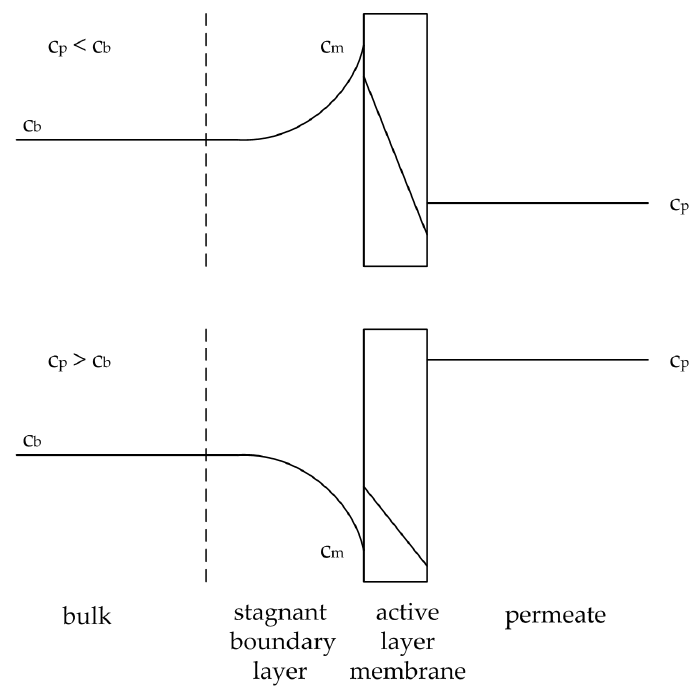
Figure 2. Illustration of the concentration polarization effect for an accumulating substance (above) and a depleting substance (below). Adapted from [17].